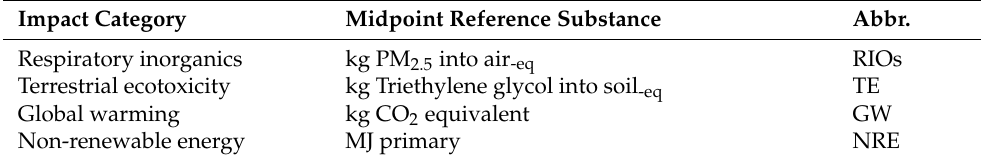
Table 5. Selected impact categories in this study.